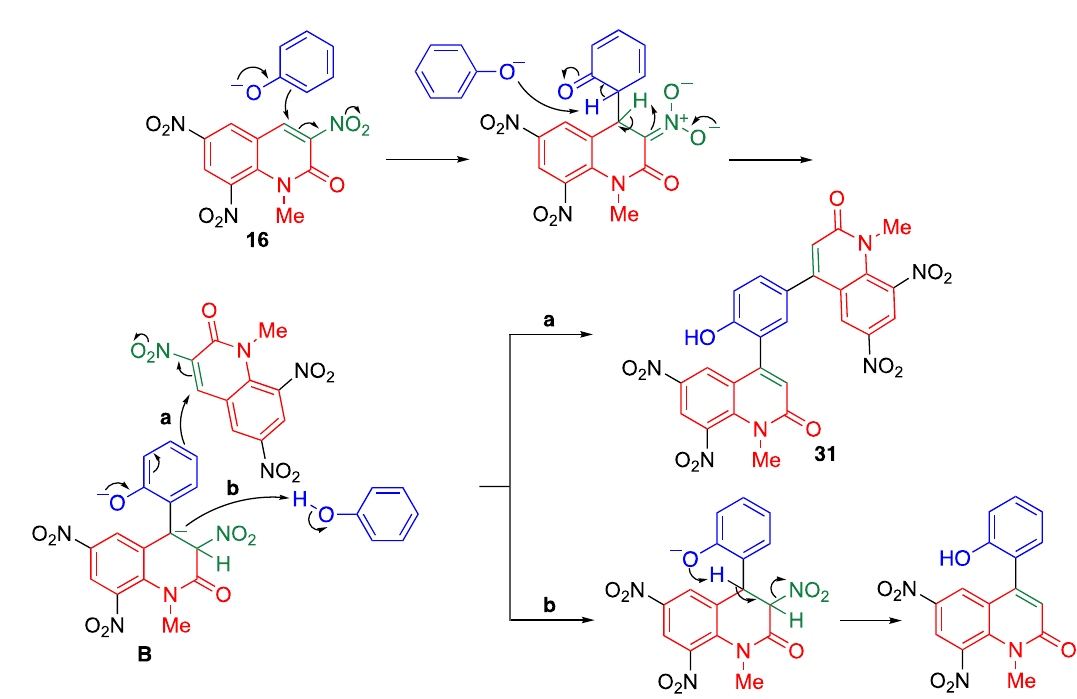
Figure 6. cine -Substituted products from 16 and potassium phenoxides.